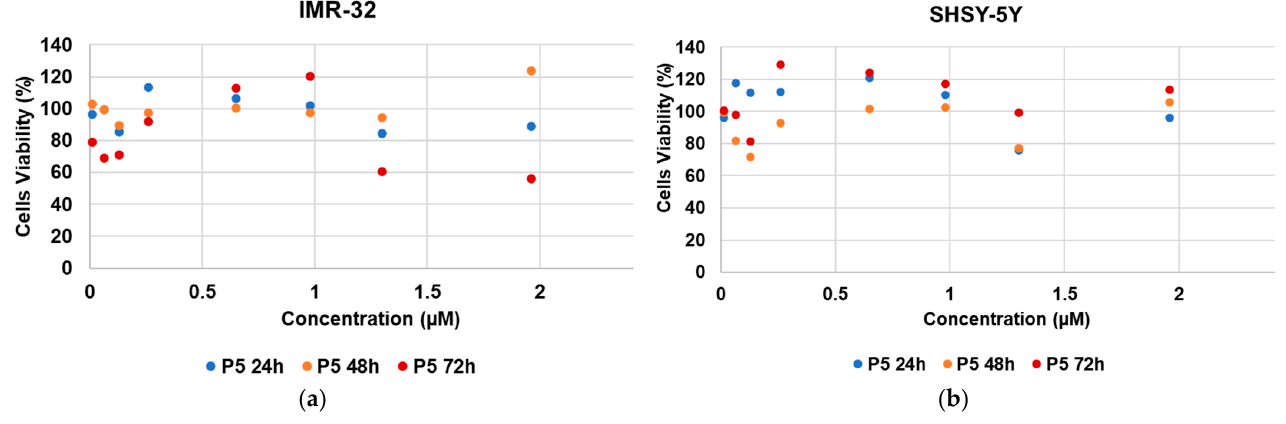
Figure 12. Dose-dependent cytotoxicity activity of P5 at 24 h (blue), 48 h (orange), and 72 h (red) in IMR-32 cells ( a ) and SH-SY5Y cells ( b ) in the range 0.013–1.96 µM.